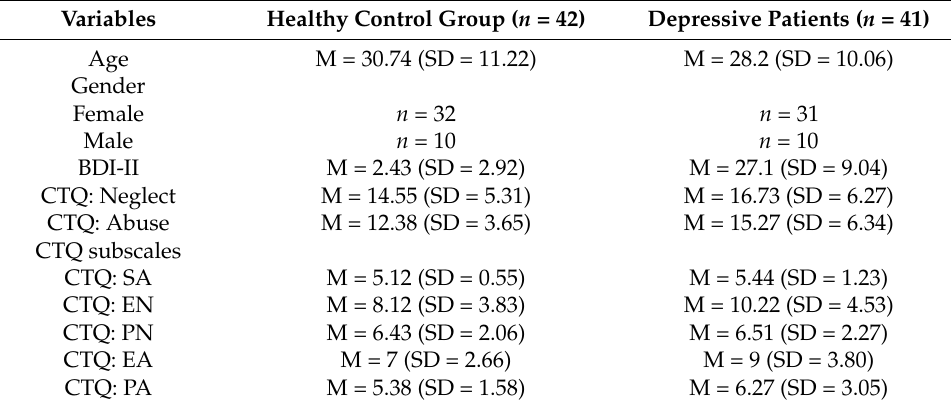
Table 1. Sociodemographic and psychometric characteristics of the sample.